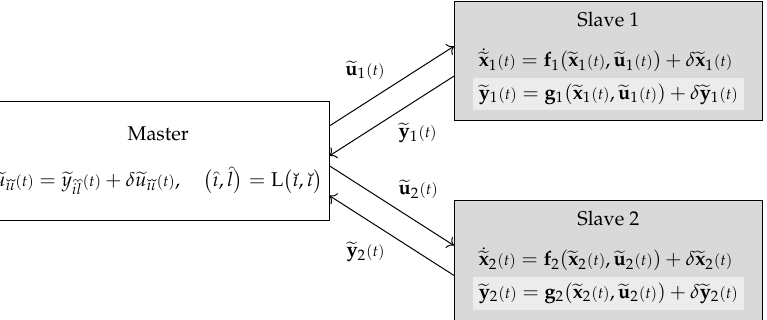
Figure 1. The underlying model for the analysis in this article is coupled ordinary differential equations [15]. Co-simulation slave equations are colored gray because they are not available to the master. Output equations are lighter colored because this article suggests that the master should estimate the output